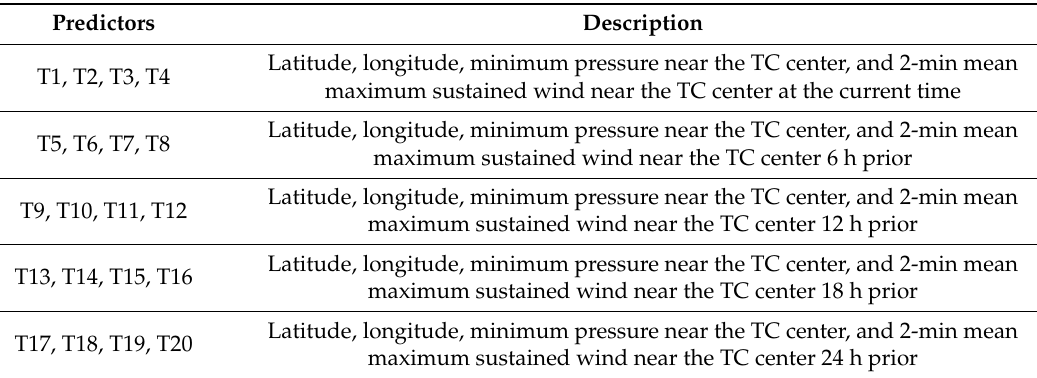
Table 2. Detailed description of the 20 persistence factors. TC: tropical cyclone.